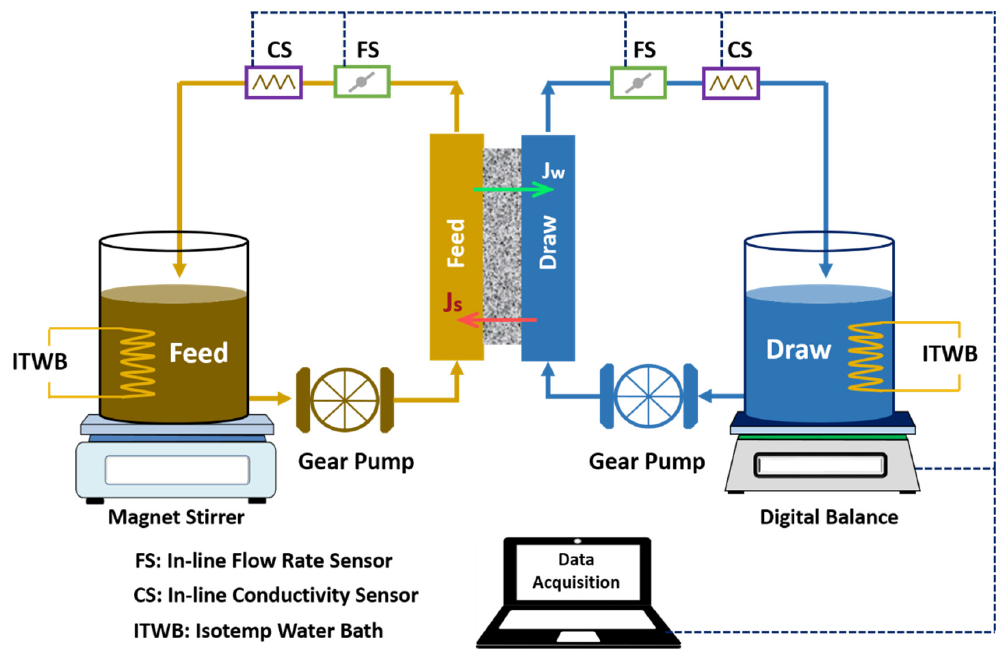
Figure 3. Schematic view of the forward osmosis (FO) setup. The flow rate and operating temperature of feed and draw solutions were set at 2.5 LPM and 25 °C.